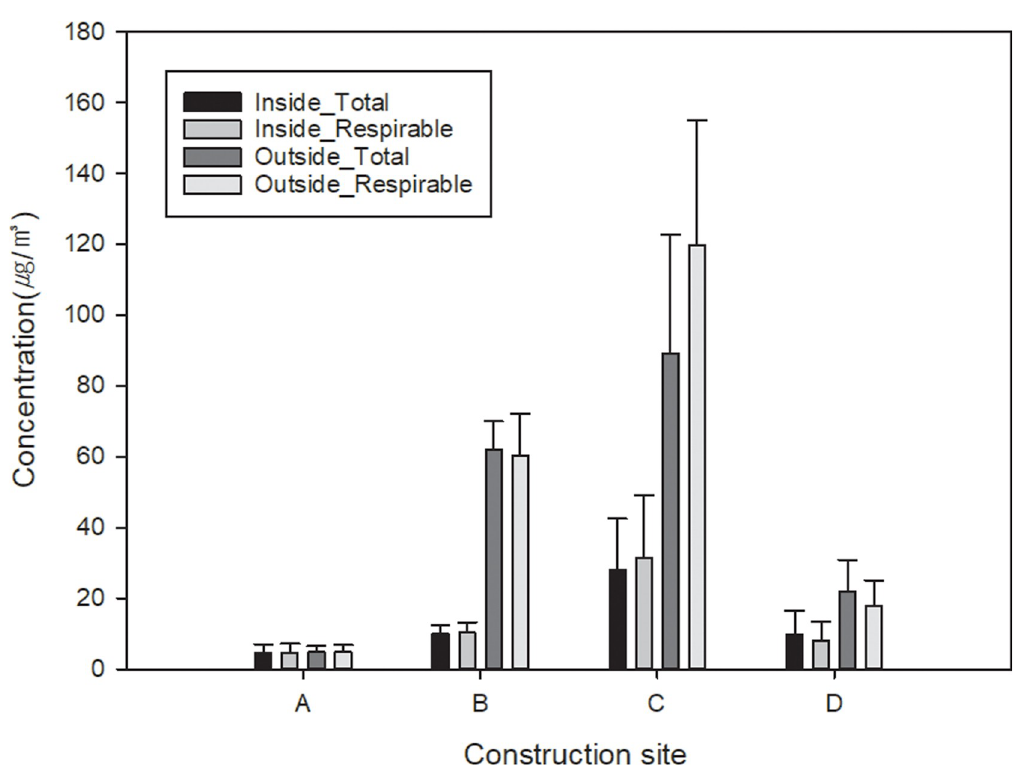
Fig 2. Mean concentration of EC, along with standard deviation (error bar), for each total and respirable particulates from inside and outside the excavator in underground excavation site.